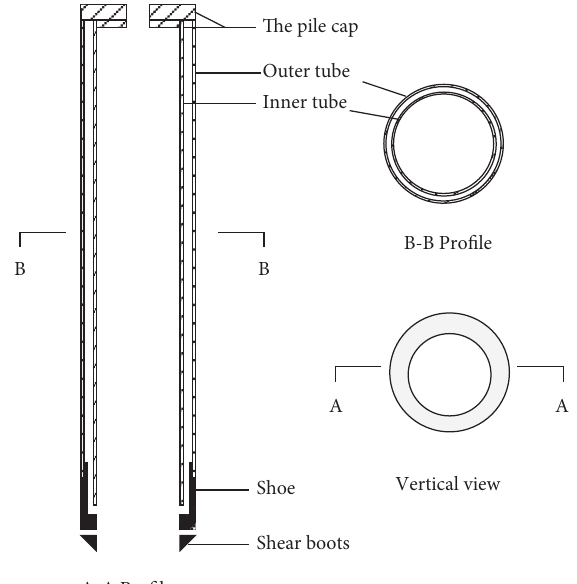
Figure 2: The structure of double-walled